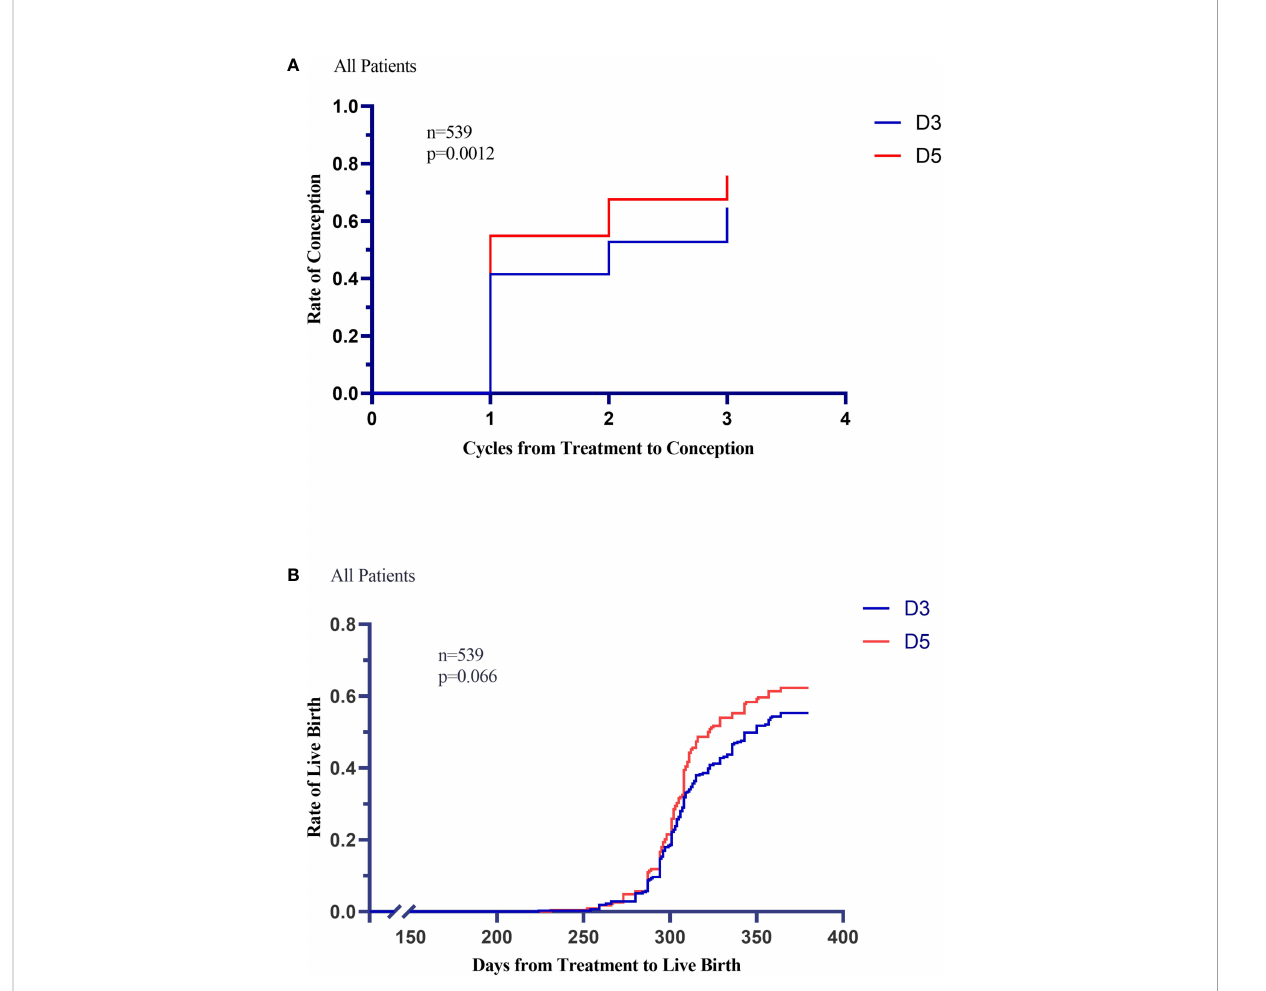
FIGURE 4 Kaplan-MeierCurvesforConceptionandLiveBirth.ConceptionratesandLive-birth ratesare shownaccordingtotreatment groupinPanel A and Panel B